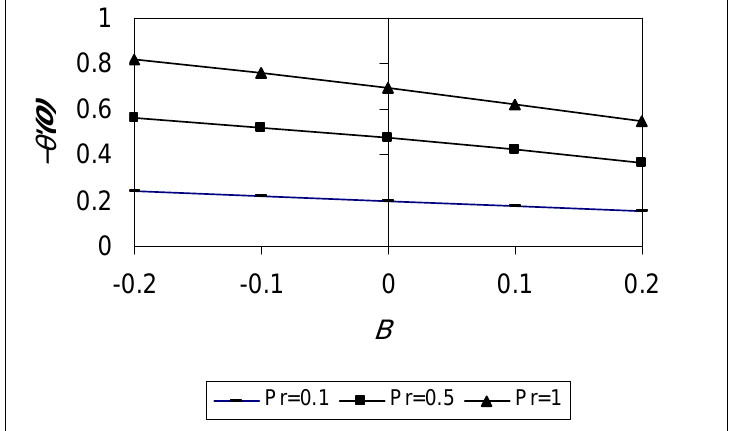
Fig. 5. Variation of the wall heat transfer rate )0( q